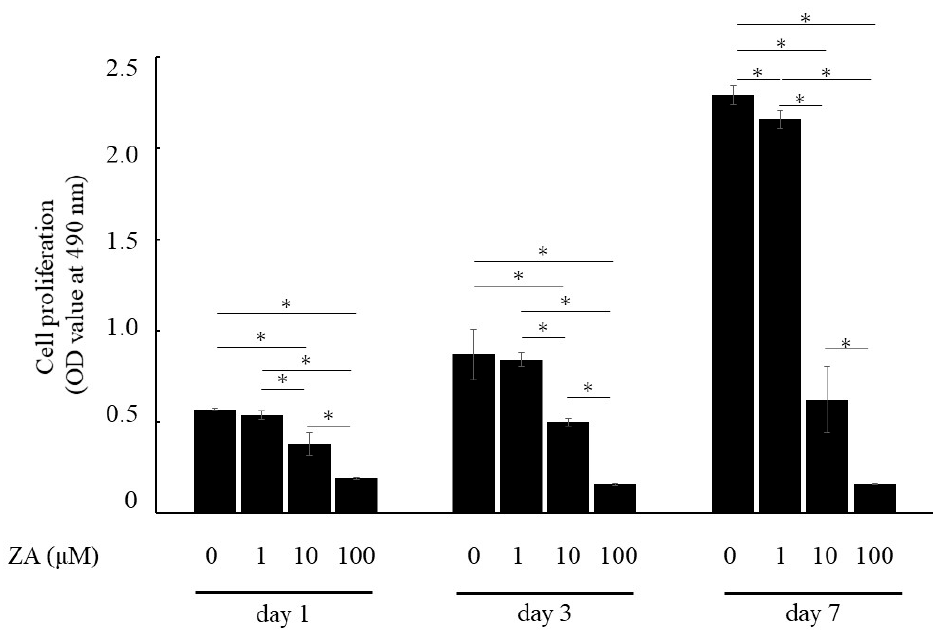
Figure 1. Influence of ZA on proliferation of MC3T3-E1 cells. Results are expressed as mean ± SD. * p < 0.05 compared with control (0 µM of ZA) of each period.